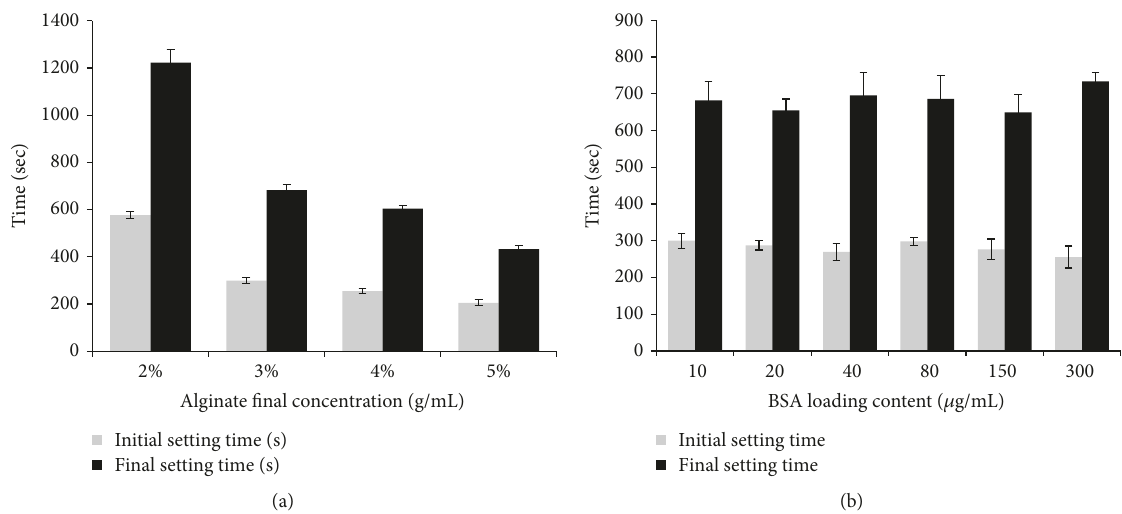
Figure 2: E ff ect to gelation time of Alg/Col/HA with di ff erent concentrations of alginate. (a) E ff ect of di ff erent concentrations of alginate on Alg/Col/HA gelation. (b) E ff ect of di ff erent concentrations of BSA on Alg/Col/HA gelation containing 4%